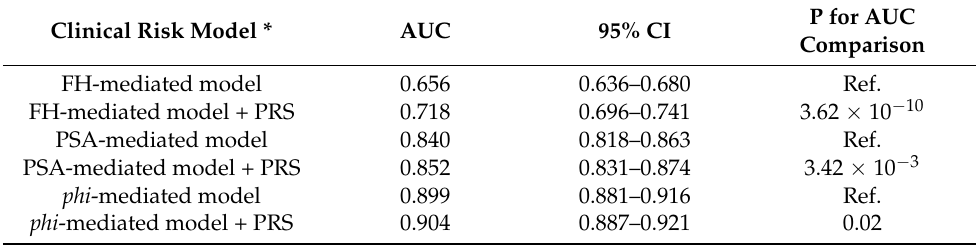
Abbreviation: FH, family history of prostate cancer; PSA, prostate-specific antigen; phi , prostate health index; AUC, area under ROC curves; CI, confidence interval. * Clinical risk model: FH-mediated model: Age + FH PSA-mediated